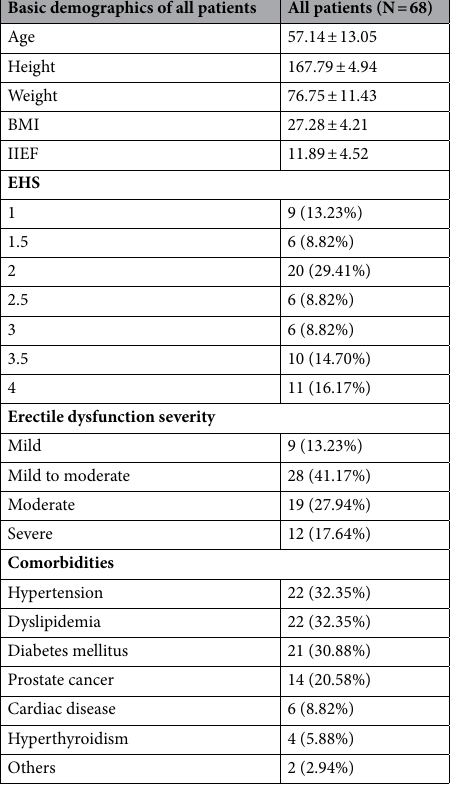
Table 1. Basic demographics of all patients. BMI Body mass index, IIEF International index of erectile function, EHS Erection hardness score.